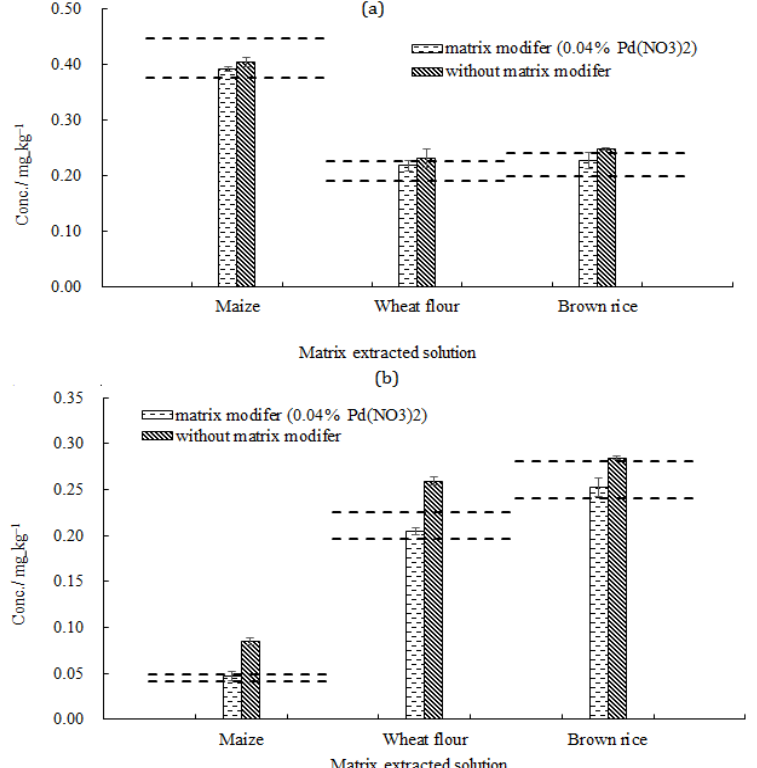
Figure 6. The influence of the matrix modifier in different matrix-extracted solutions (n = 3): ( a ) Pb; ( b ) Cd. The dotted line represents the expanded uncertainty of the certified value. U crm = k · u crm ( k = 2).